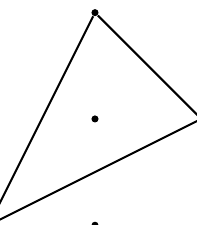
Figure 11. The Higgsing of nodes 0 and 3 on the quiver of dP 1 gives the quiver of C 3 = Z 3 .